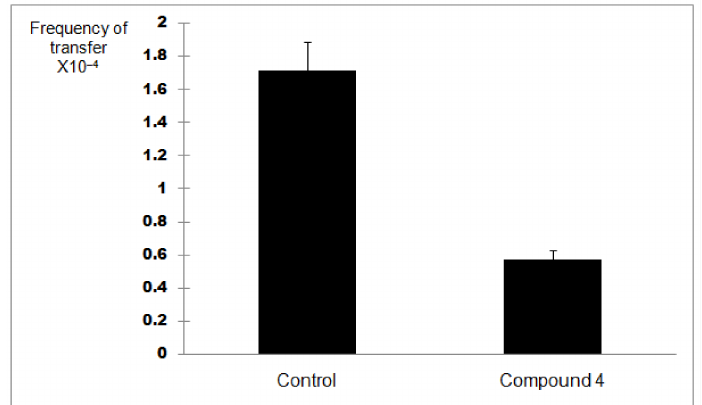
Figure 4. Bar graph showing the inhibitory activity on pKM101 plasmid conjugation of compound 4 in E. coli when compared with the control ( p < 0.05). The transfer frequency is expressed as the number of transconjugants per donor cell obtained from